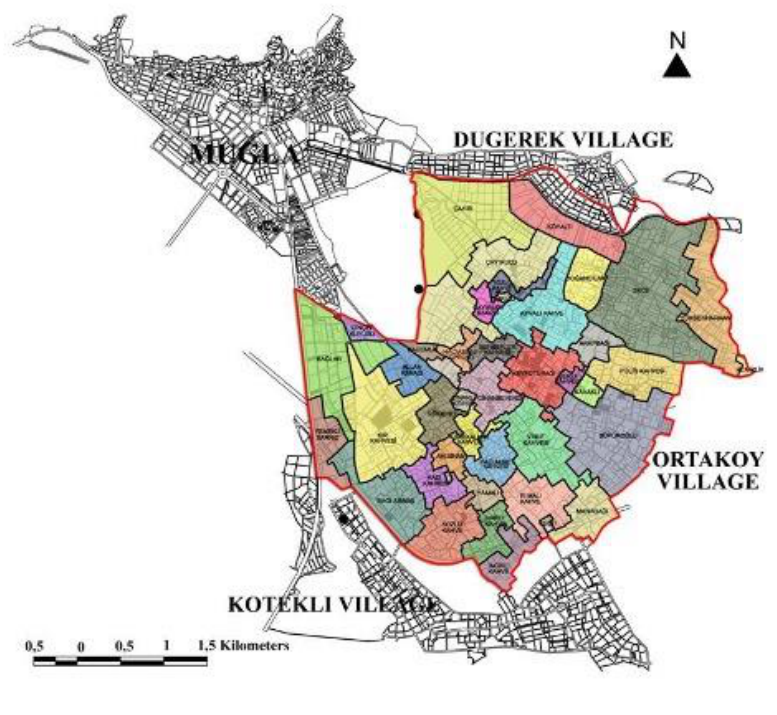
Figure 5 Karabağlar and its 48